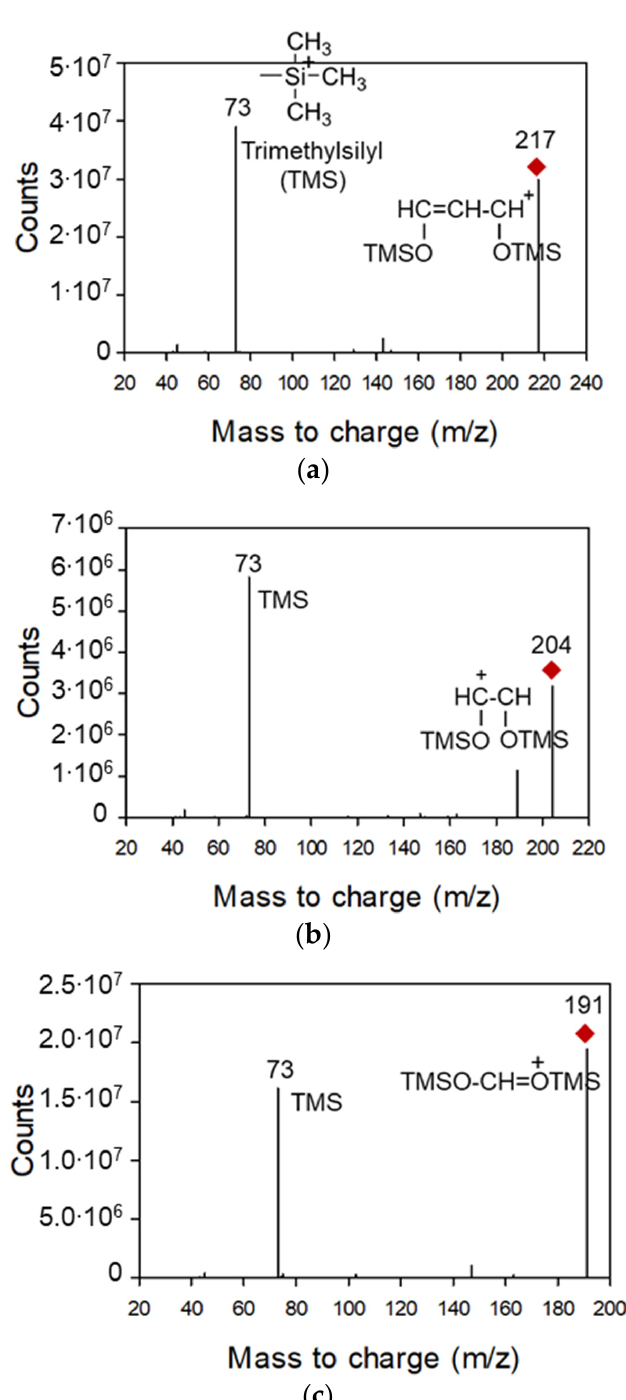
Figure 2. Product ion spectra of derivatized ( a ) arabinose (precursor ion: m/z 217), ( b ) levoglucosan (precursor ion: m / z 204), and ( c ) xylose (precursor ion: m / z 191).